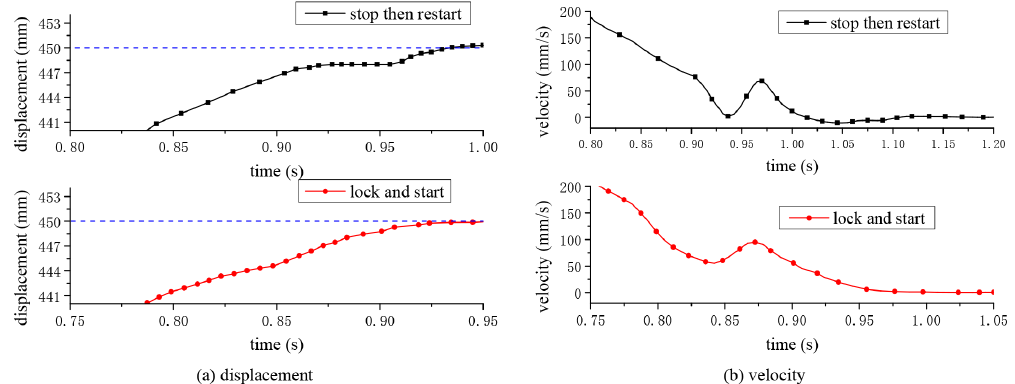
Figure 16. Comparison of the positioning test of 0–450mm with the strategies of lock and start and stop then restart.